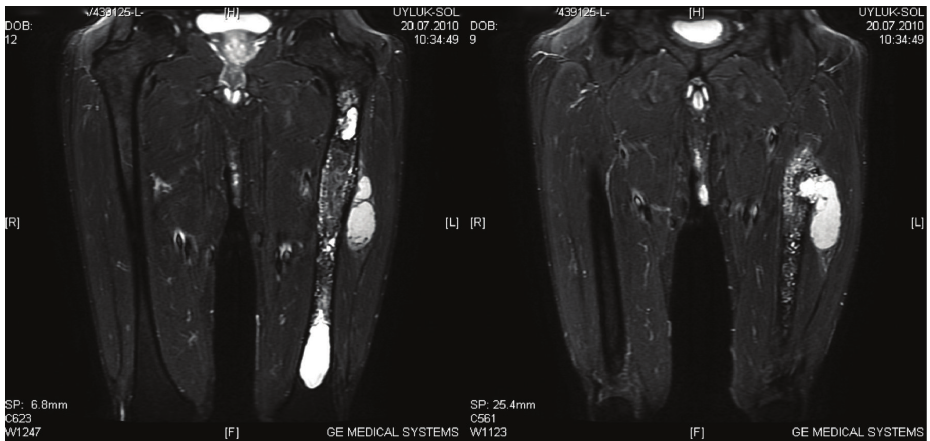
Figure 2: T2-weighted MRI views showing the bony involvement and the soft tissue extent.